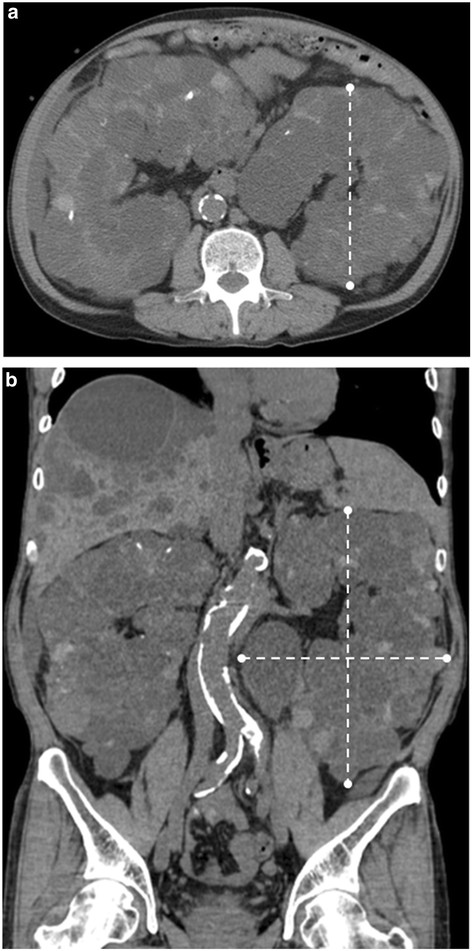
Computed tomography showing innumerable cysts of variable size in both kidneys and the liver. (A) Axial and (B) coronal unenhanced computed tomography showing enlarged kidneys and multiple liver cysts. The three greatest diameters of the kidney are indicated by dashed lines. No tumors were identified in other organs.